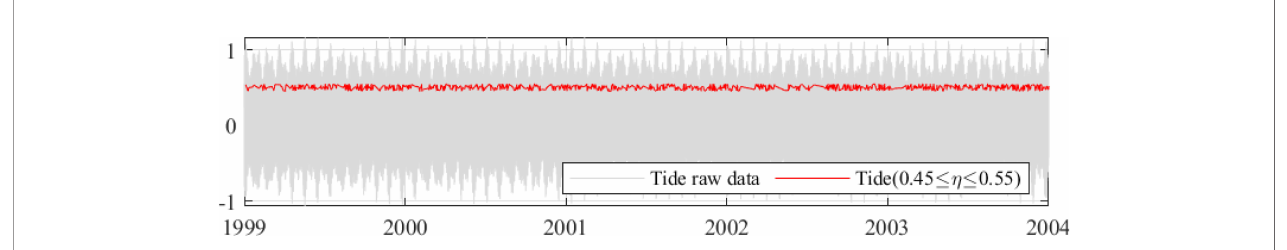
FIGURE 5 | Tide raw data (gray line) and tide data at the time of shoreline observation data (red